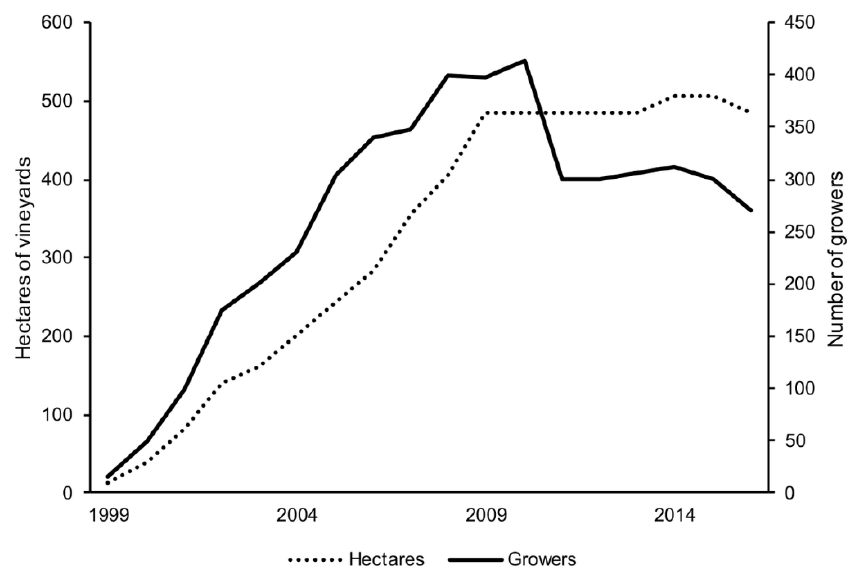
Figure 1. The increase in hectares of wine grapes and the number of growers in Iowa [2].